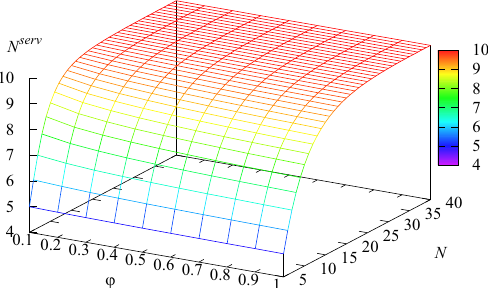
Figure 3. Dependence of the mean number of busy servers N serv on ϕ and N .